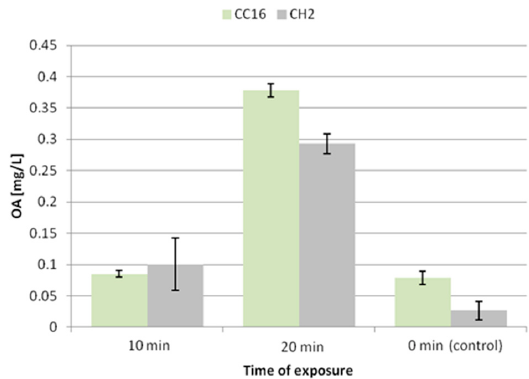
Figure 7. The content of oleanolic acid in the medium after elicitation with ultrasound. OA—oleanolic acid.